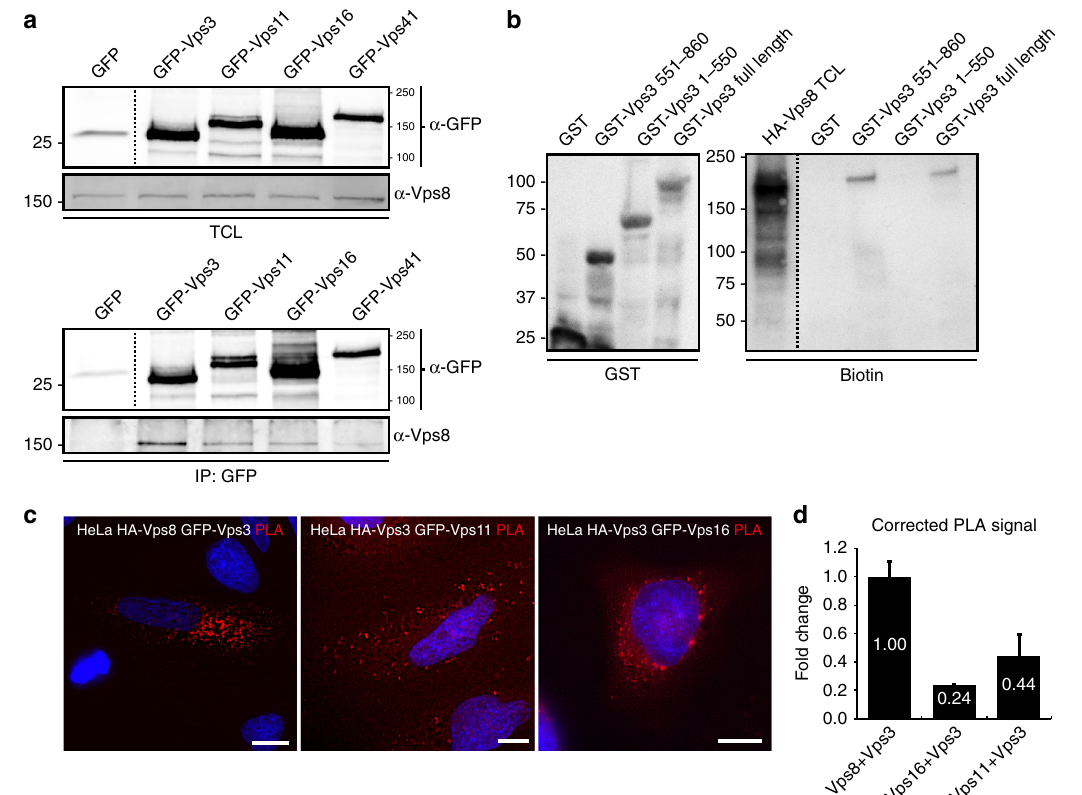
Fig. 2 Vps3 and Vps8 interact with each other. a IPs of GFP-tagged Vps3, Vps11, Vps16 or Vps41 probed for interaction with endogenous Vps8 (GFP control lane shows area around 25 kDa from the same membrane). b IPs of GST-tagged Vps3 and truncation mutants of GST-Vps3 puri fi ed from bacterial lysates (left panel) probed for interaction with in vitro-translated HA-Vps8. In vitro translation was performed with biotinylated lysines using the Transcend Non-Radioactive Translation Detection System (Promega) according to the manufacturer ’ s protocol and detected using streptavidin-HRP. HA-Vps8 binds to the C terminus of Vps3 and full-length Vps3. c PLA on HeLa cells. The highest PLA signal is between Vps3 and Vps8. Bar, 10 µ m. d Quanti fi cation of triplicate experiments shown in c based on n > 30 cells per condition, PLA signal corrected for protein expression and cell size. Error bars represent standard deviation of the mean